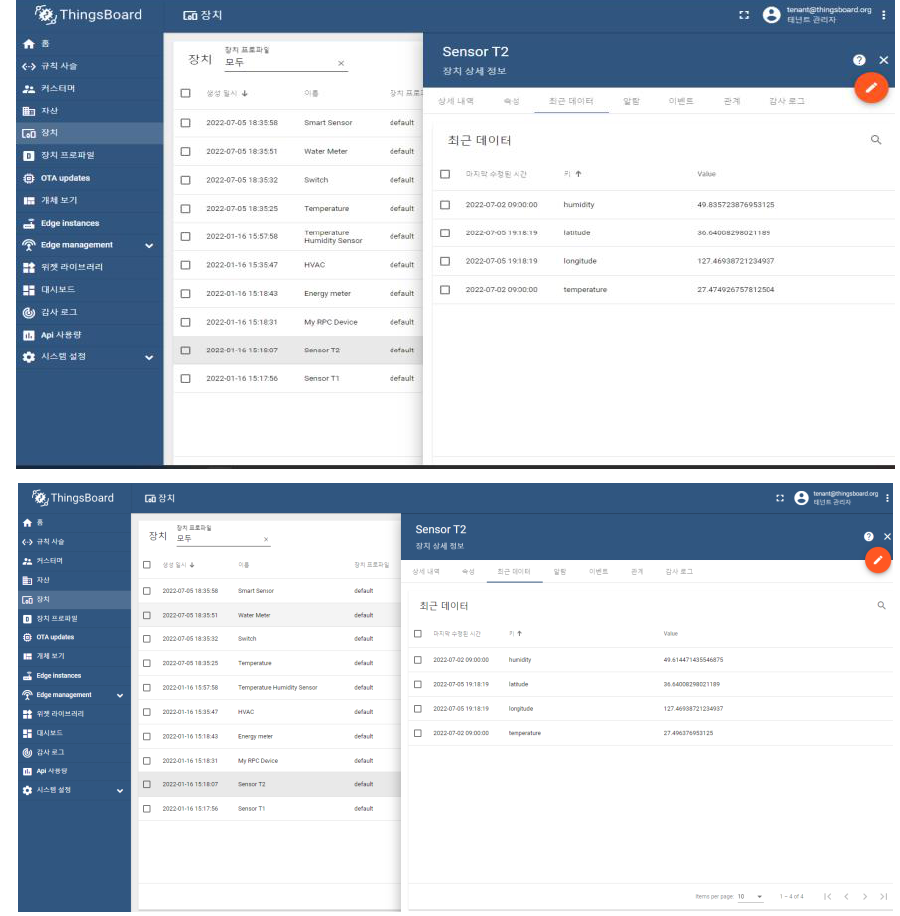
Figure 8. Data validity check result from sensors(For your information, In this figure, the non-English term “ 장치 ” means “device” in English) .